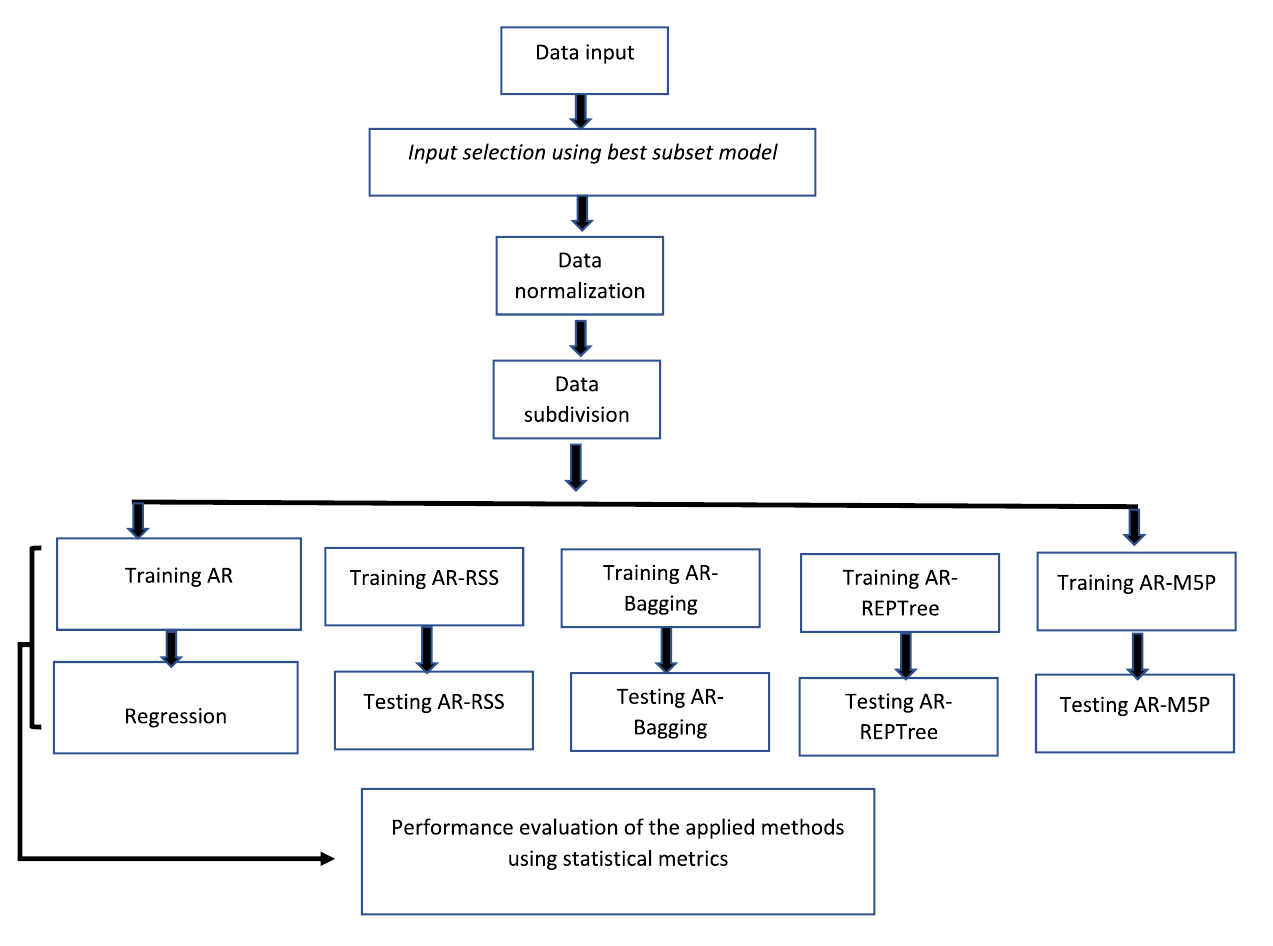
Fig. 2 The flowchart of the proposed